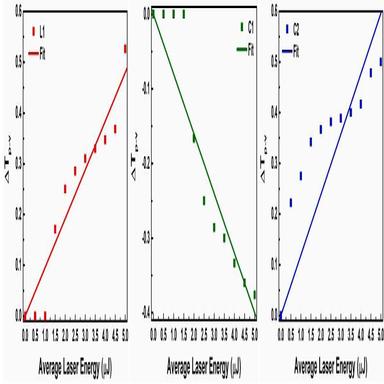
ΔTp-v values as a function of the average laser energy of studied complexes.